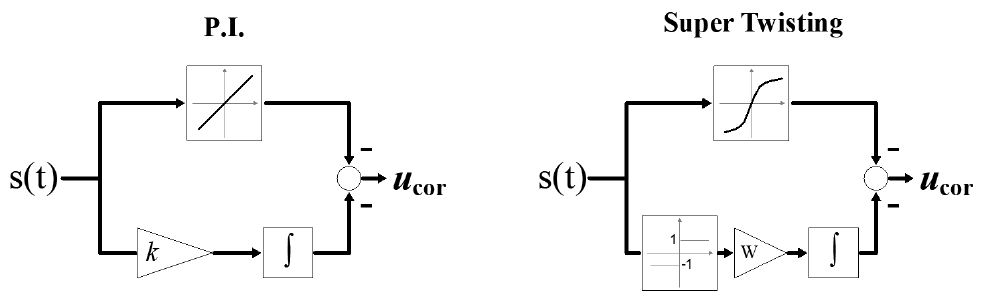
Figure 4. Block diagram of PI ( left ) and super-twisting ( right ) controllers.